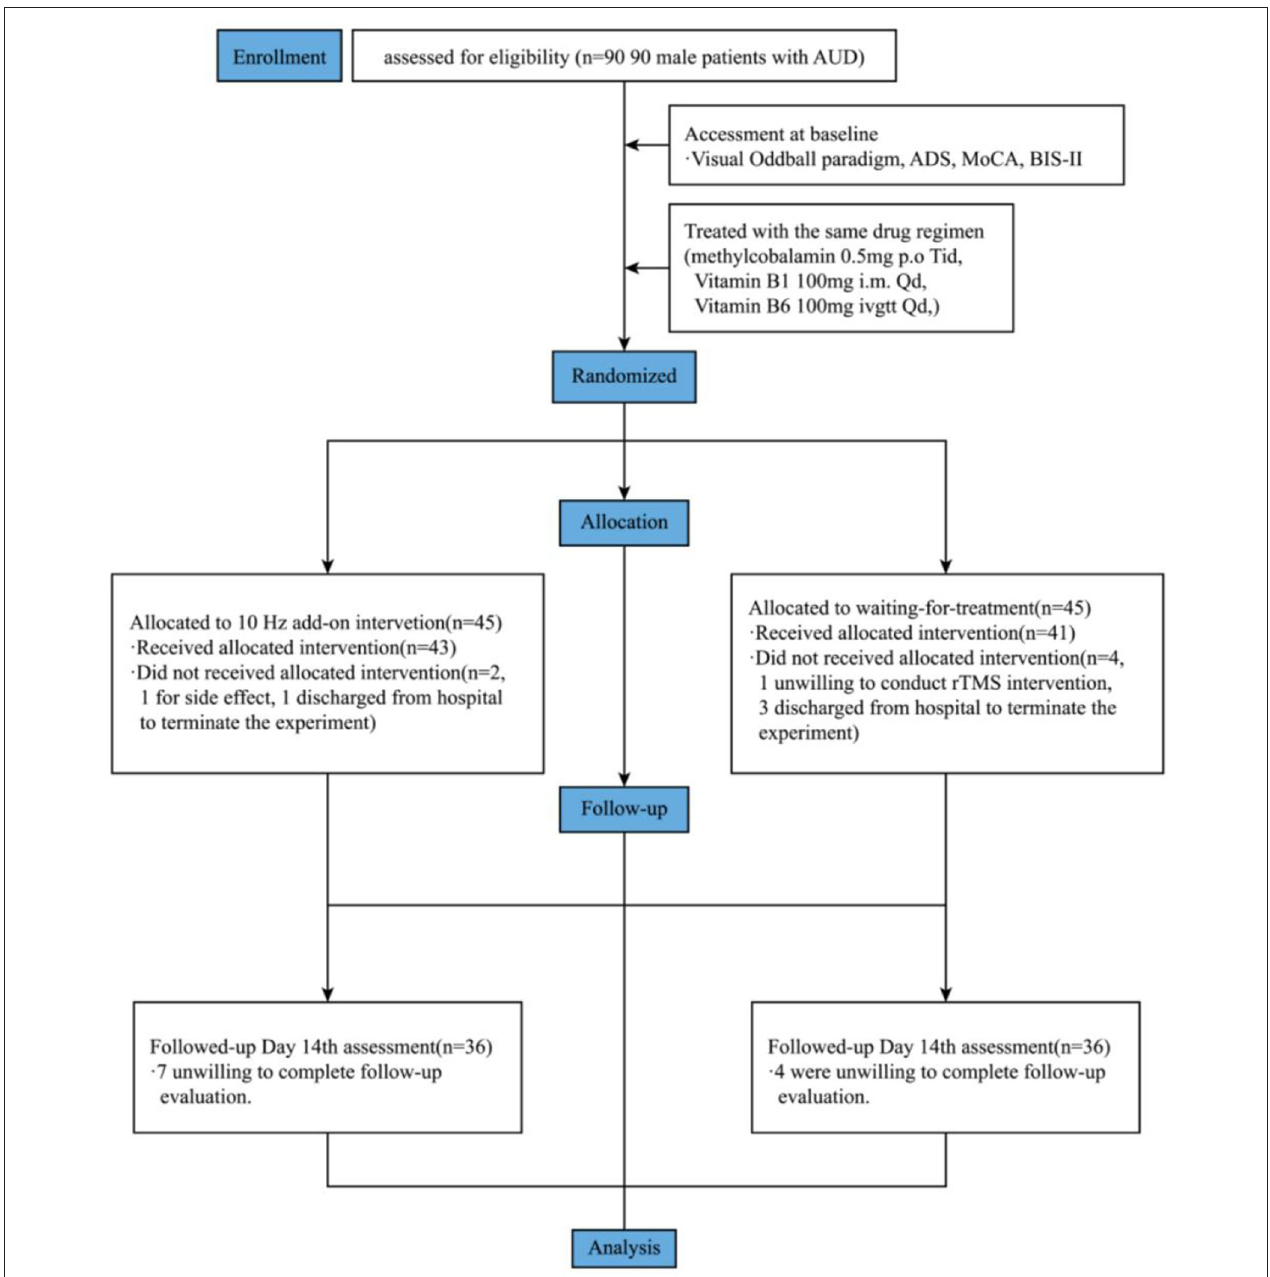
FIGURE 2 | Flowchart of study. ADS, Alcohol dependence scale. MoCA, Montreal Cognitive Assessment; BIS-II, Barratt impulsiveness